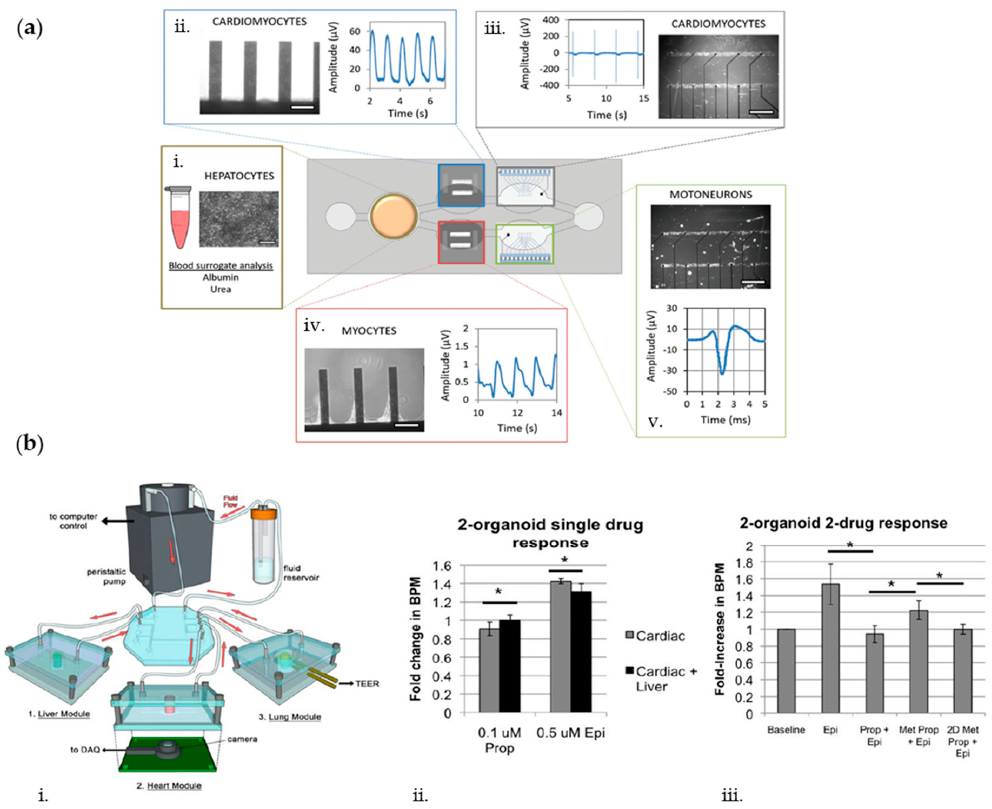
Figure 8. ( a ) Schematic of the pumpless four-organ microfluidic system, showing the acrylic housing holding PDMS gaskets that define the microfluidic pathway and the organ compartments along the path: representative images of hepatocytes on coverslip (i), cardiomyocytes on cantilever chip (CL) (ii) and patterned on customized MEA (cMEA) chips (iii), skeletal muscle myotubes on CL chips (iv), and motoneurons patterned on cMEA chips (v) show each cell type in a different location in the system. Representative functional readouts of the coculture are shown for the different compartments: the supernatant is used to quantify hepatic function (i); the contractile machinery of cardiomyocytes and myotubes is challenged on the CL chips using a laser-deflection based apparatus that records CL movement and a wave amplitude (ii and iv); the electrical signal of cardiomyocytes and motoneurons is recorded from the cMEAs connected to an amplifier via a printed circuit board and an elastomeric connector, translating current changes detected on the electrodes into field potential waveforms (iii and v). Adapted from Ref. [176] with permission from Advanced Functional Materials. ( b ) Schematic of the modular perfusion-driven three-organ-on-a-chip microfluidic system (i): individual microfluidic microreactor units house each organoid or tissue model and are connected via a central fluid routing breadboard. Quantitative analysis of cardiac beating rates (ii) following incorporation of liver organoids show an altered response of the cardiac organoids to both 0.1 µM propranolol and 0.5 µM epinephrine. The assessment of the interplay between the two drugs (iii) shows that BPM (Beats per Minute) values increase from baseline with epinephrine 0.5 µM and increases from epinephrine are blocked by 0.1 µM propranolol in the cardiac organoid-only system. When liver organoids are present and permitted to metabolically inactivate 0.1 µM propranolol, 0.1 µM epinephrine induces an increased BPM value. If 2D-cultured hepatocytes are substituted for the liver organoids, this effect is not observed. Statistical significance: * p < 0.05. Adapted from Ref. [178] with permission from Springer Nature.